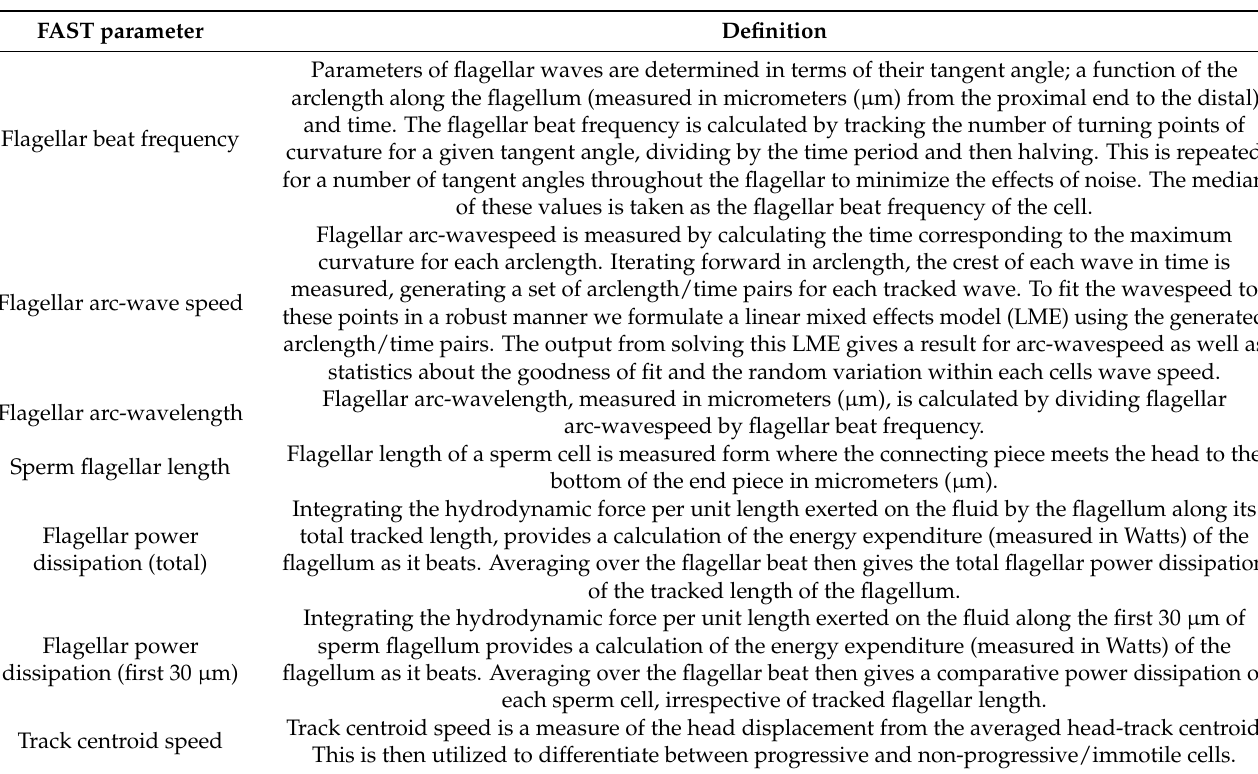
Table 2. Definition of FAST flagellar parameters and how they are